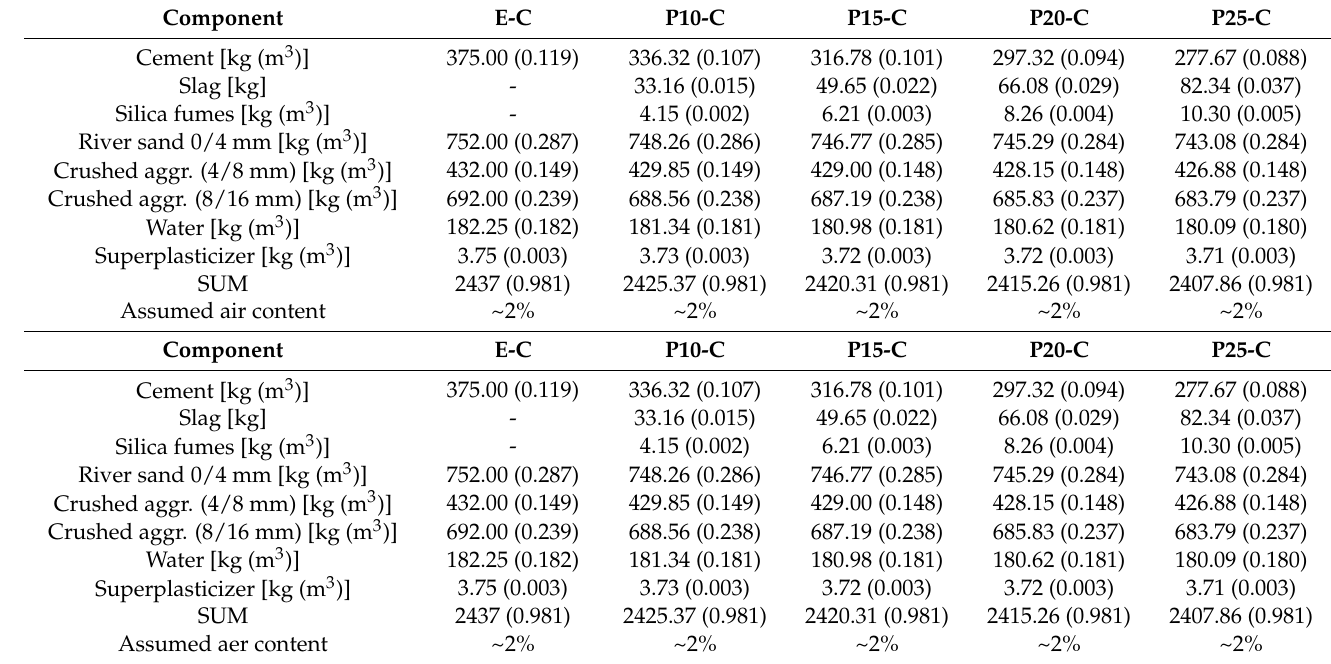
Table 3. Mix proportion of concrete mixtures for 1 m 3 of